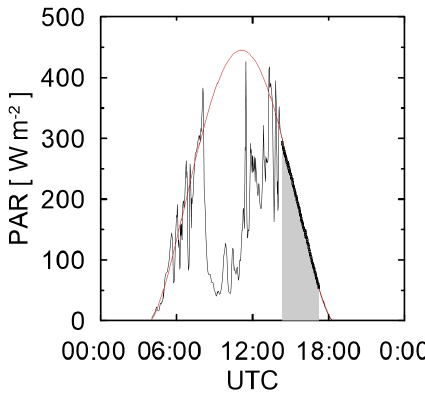
Figure 5. PAR measured during 4 June 2016, a partially cloudy day (black line). The cloud-screened data are shown as black dots, and the cloud-free fitting function is shown in red.